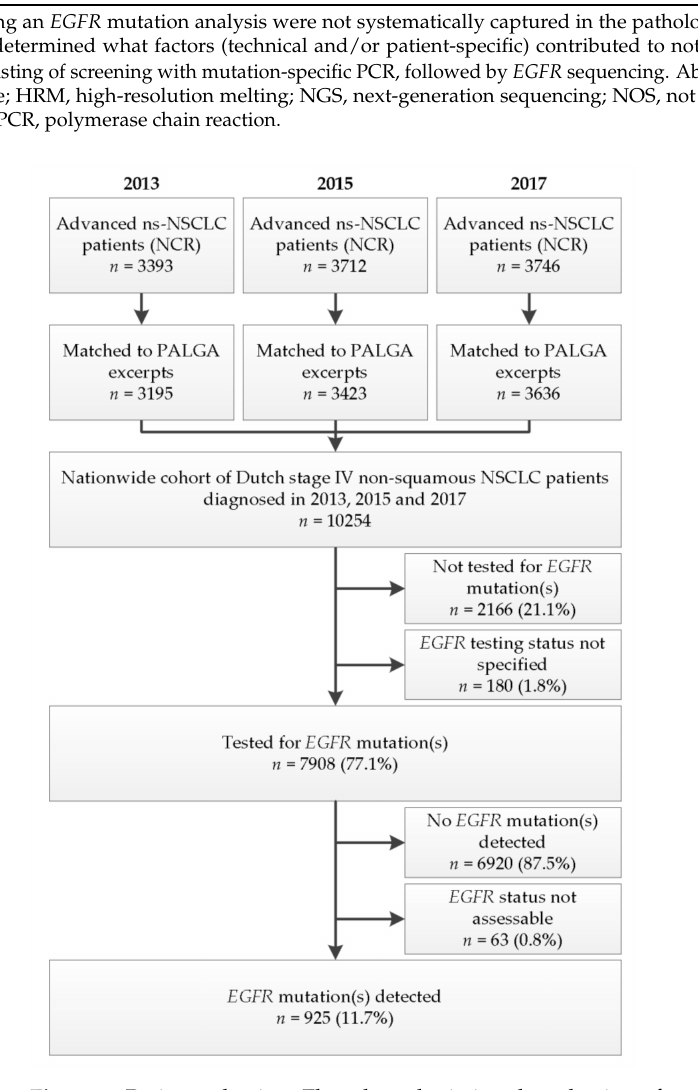
Figure 2. Patient selection. Flowchart depicting the selection of patients for inclusion in this study. Abbreviations: EGFR , epidermal growth factor receptor gene; PALGA, Dutch Pathology